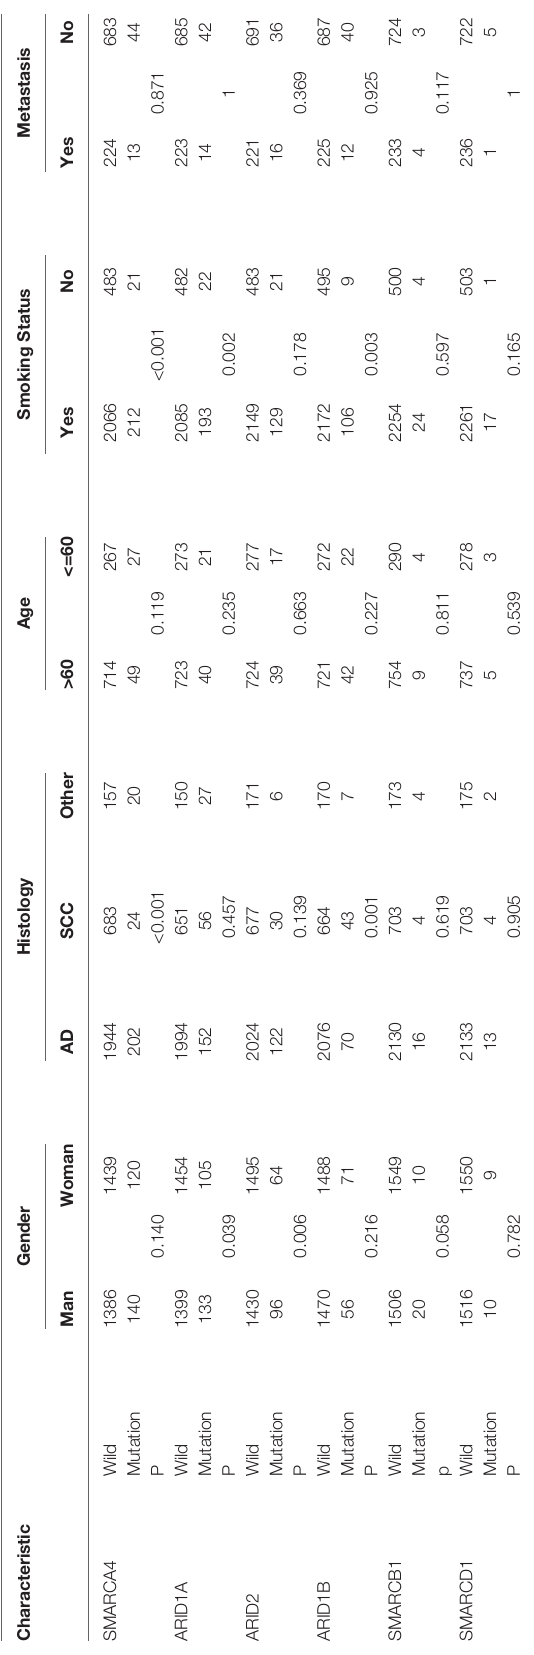
( Figure 2D ). However, due to the small number of patients, the mutation group in the HRN cohort ( Figures 2C, D